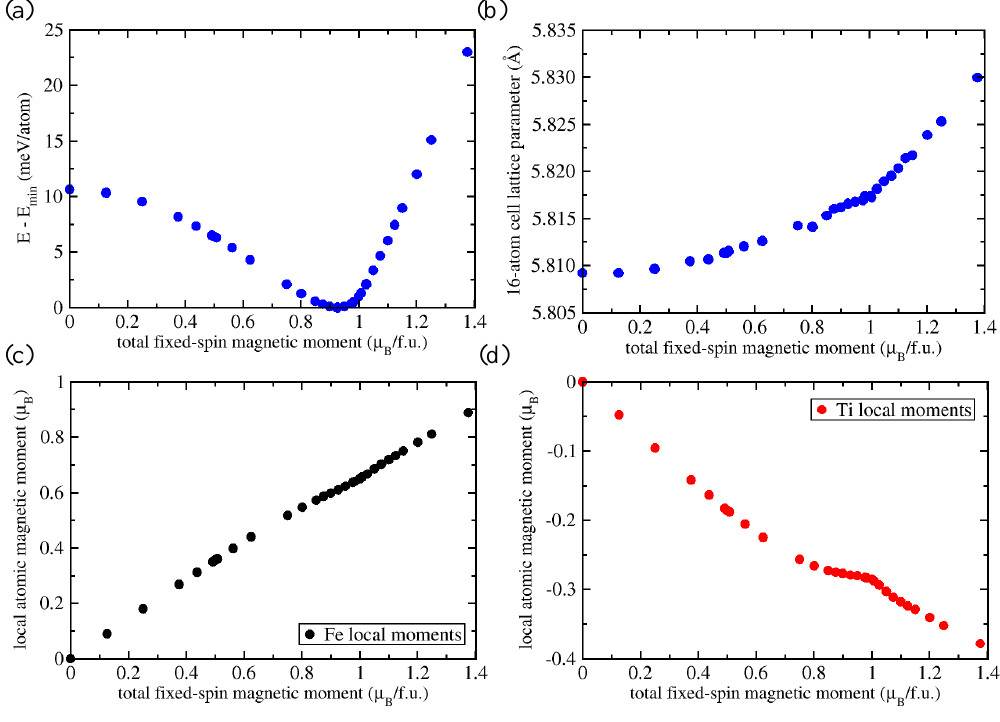
Figure 2. Computed dependencies of ( a ) the total energy (referenced to the lowest obtained energy), ( b ) a 16-atom supercell lattice parameter and local magnetic moments of ( c ) Fe and ( d ) Ti atoms as functions of the fixed-spin value of the total magnetic moment per formula